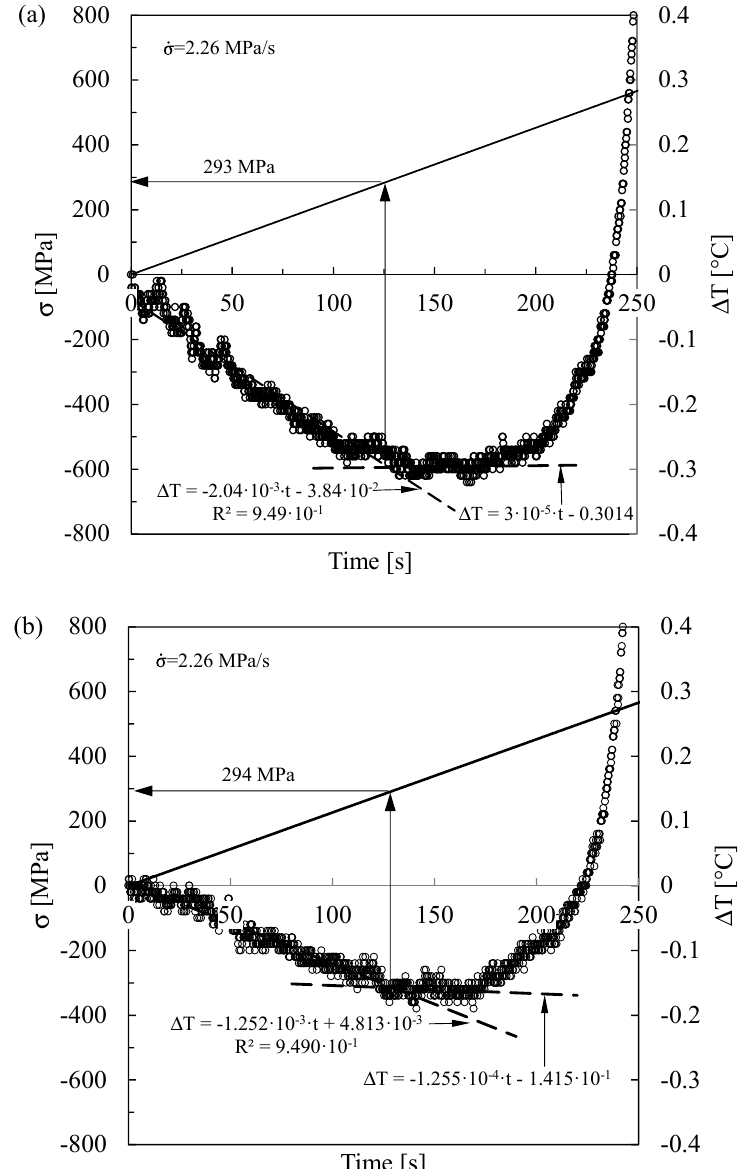
Figure 15. Material temperature evolution during the tensile static test on specimen 1 ( a ) and specimen 2 ( b ).